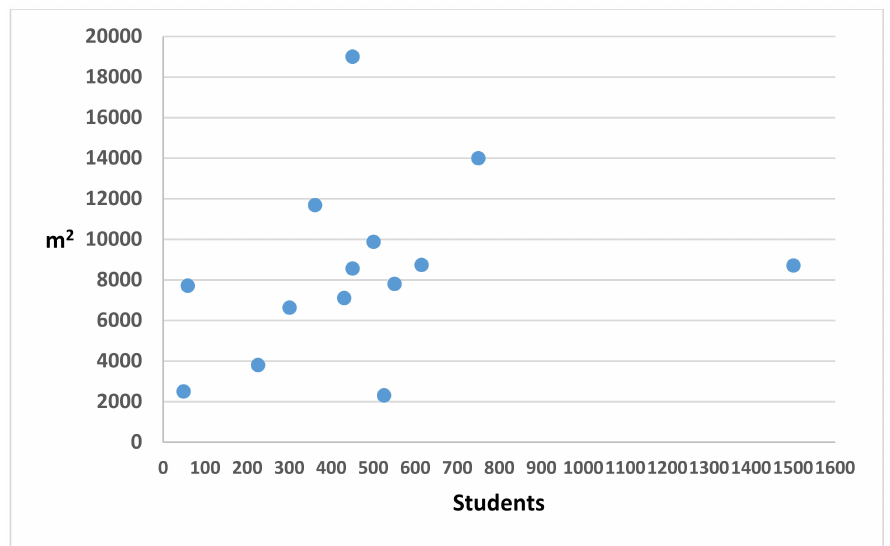
Figure 3. Schools according to the size of the plot (m 2 ) and the number of students. Source: survey results. Own elaboration.